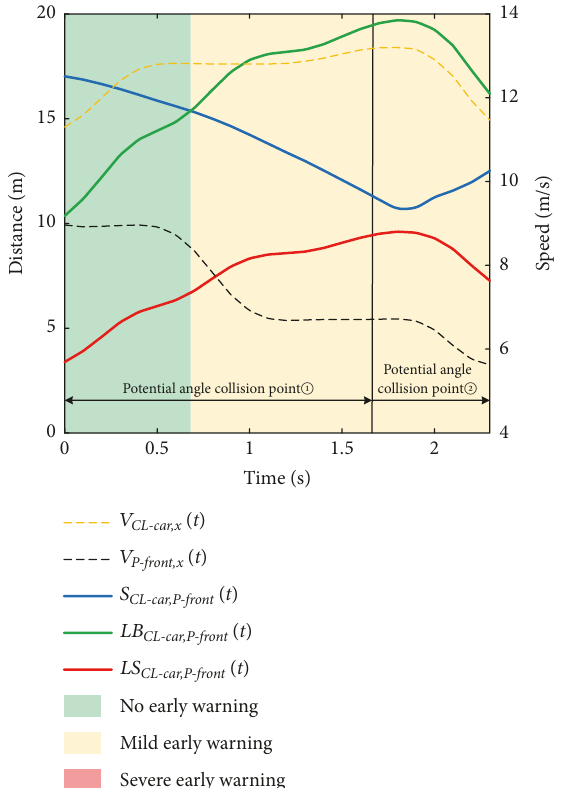
Figure 21: Distance and speed change between CL-car and P-front .